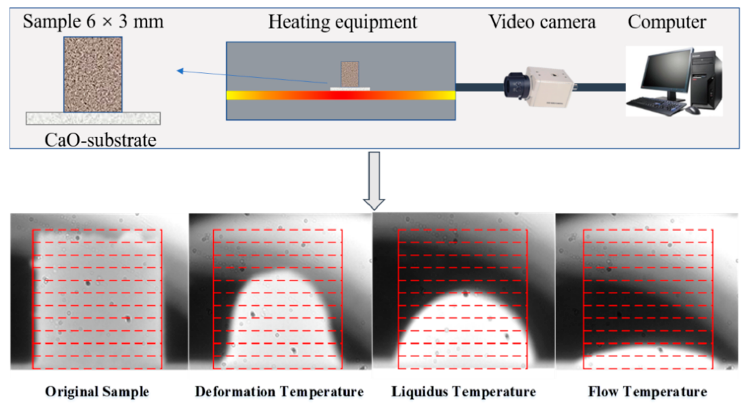
Figure 3. Hemispherical point method.